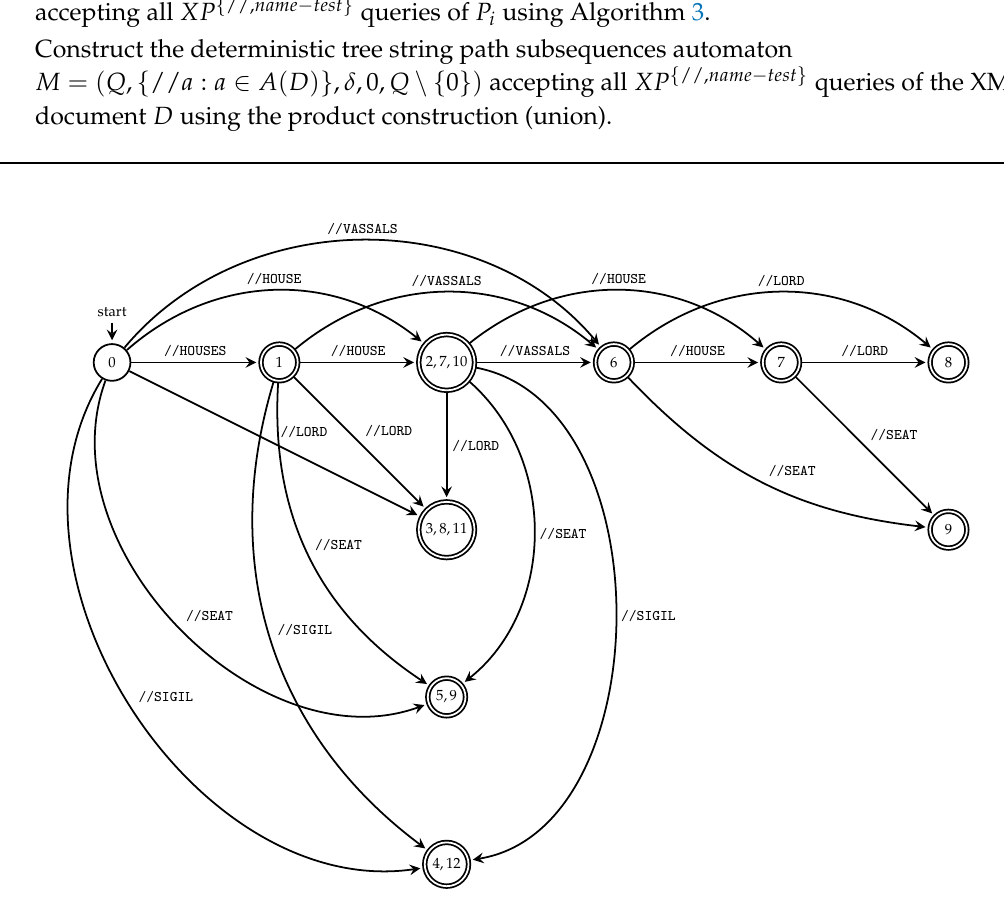
Figure 5. Deterministic tree string path subsequences automaton for the XML tree model T from Figure